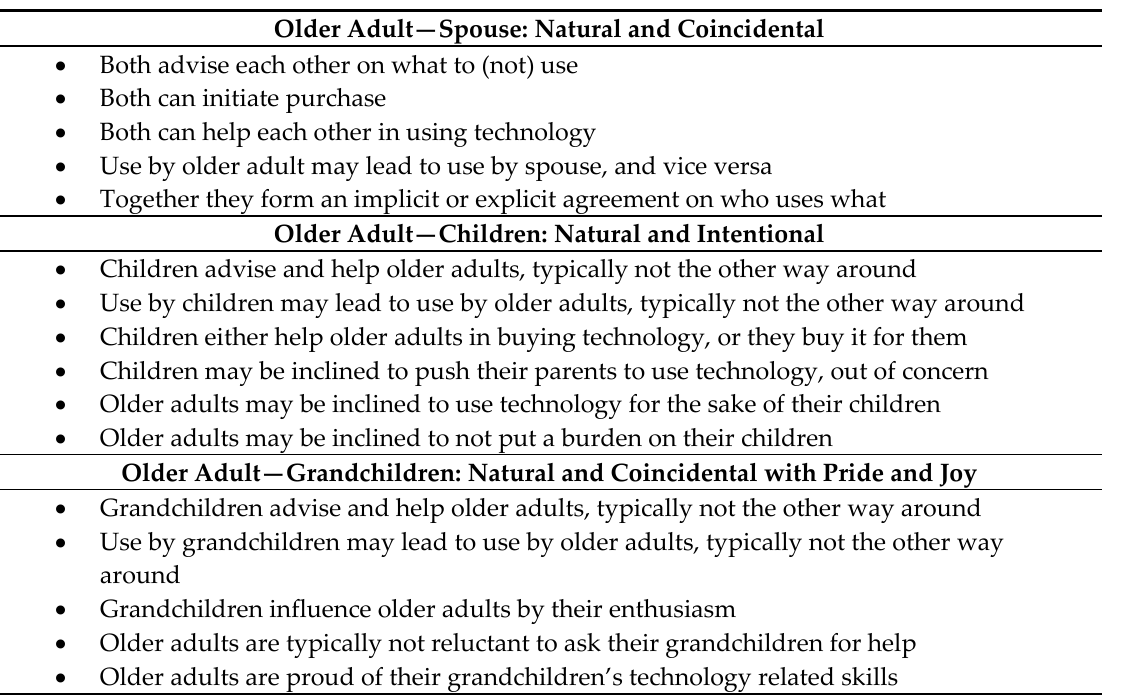
Table 2. Summary of